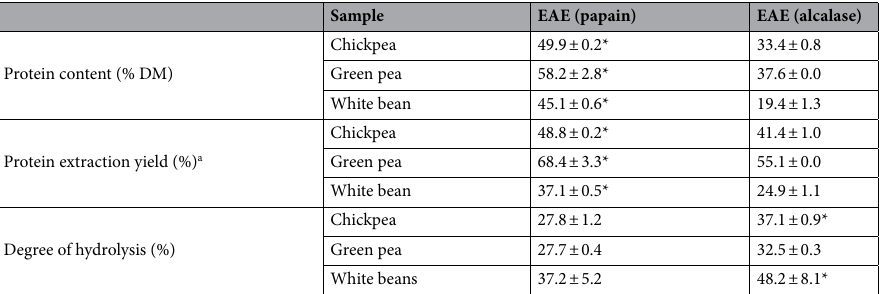
Table 3. Protein content, protein extraction yields and degree of hydrolysis of enzyme-assisted extraction (EAE) on chickpea, green pea, and white bean. a Protein extraction yield has been calculated by was calculated as the ratio between the quantity of extracted proteins and the total amount of proteins in the feedstock (in %). *statistically significant differences between the same sample treated with the two different enzymes are highlighted by the asterisk (two-tail t-test for equal variances, α =